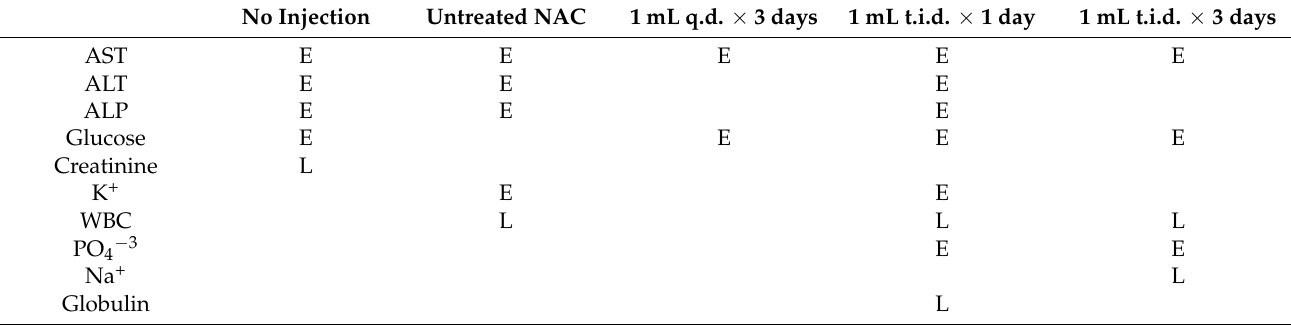
Table 2. Some important blood parameter observation on acute systemic toxicity against high, and ultrahigh doses of 3-min plasma-treated NAC solution. The variations in blood parameters are compared to normal reference values of rats. E, slightly elevated as compared to reference value; L, relatively lowered as compared to reference value; AST, aspartate transaminase; ALT, alanine transaminase; ALP, alkaline phosphatase; WBC, white blood cells. All other values are within the normal range. A q.d., once a day; t.i.d., three times a day, for indicated